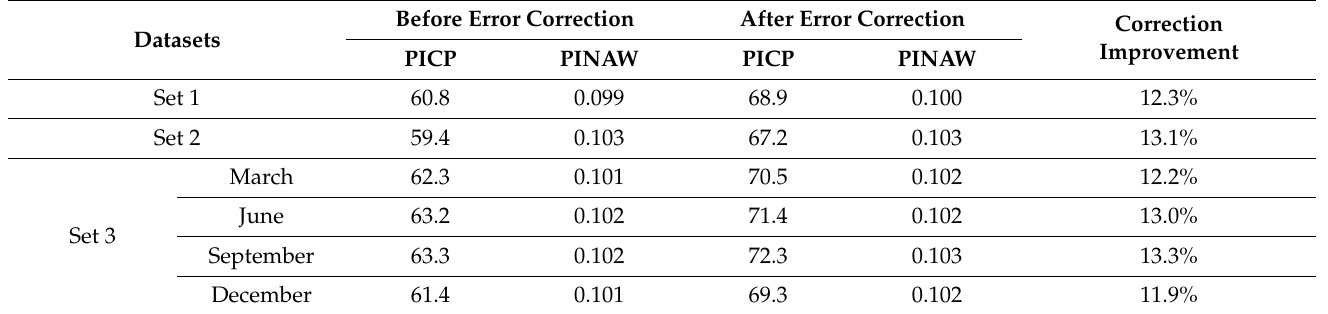
Table 4. Accuracy comparison before and after error correction in different datasets.